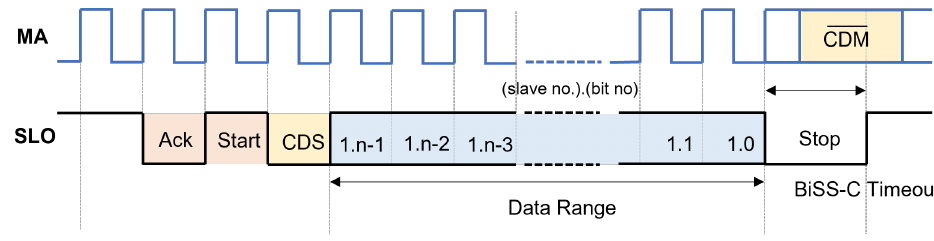
Figure 2. BiSS-C frame in a point-to-point configuration.